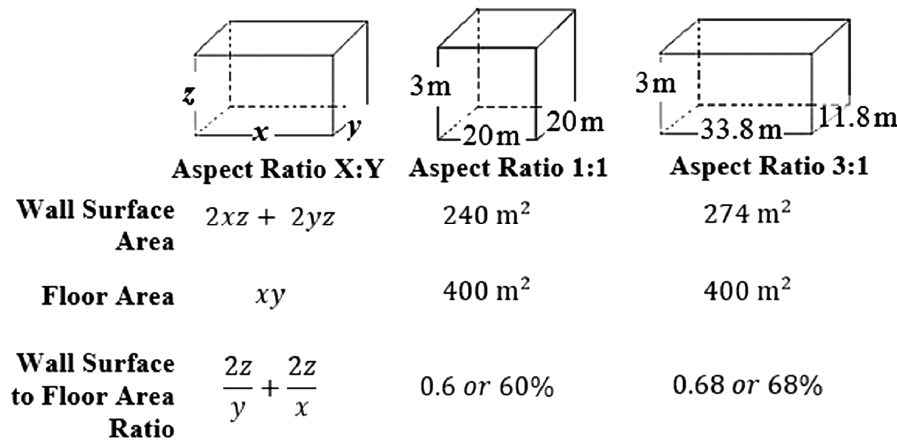
Figure 3. Geometrical relationship between surface area and the aspect